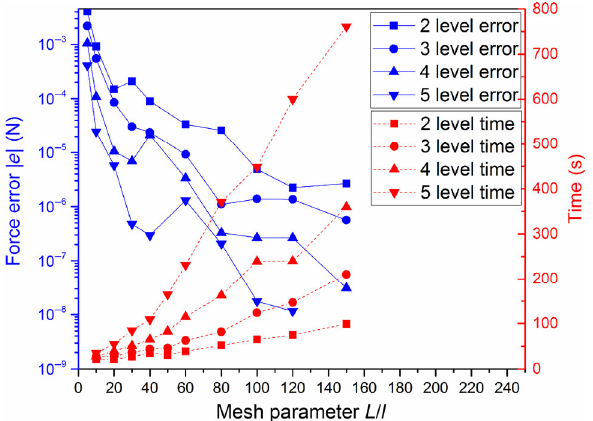
Fig. 4 Accuracy and computing efficiency evaluation of the adaptive mesh refinement. L is the ABS length and l is the maximum size of the initial uniform triangle mesh. Mesh parameter L / l represents the initial mesh